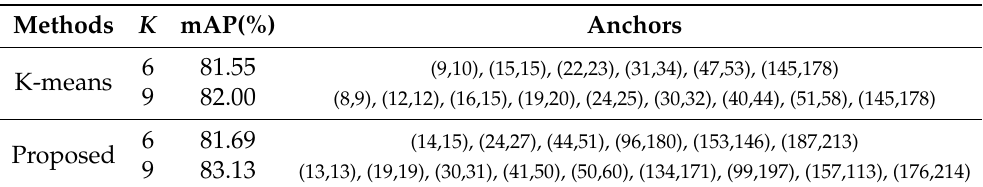
Figure 9. The loss function curve using anchors obtained by different algorithms. After obtained the optimal anchor setting, the detection accuracy achieved by adding three prediction layers are shown in Table 8. Compared with K-means clustering, the proposed algorithm can improve the detection accuracy by 1.13% in terms of mAP when using 9 anchors. Table 8. The performance of different anchor